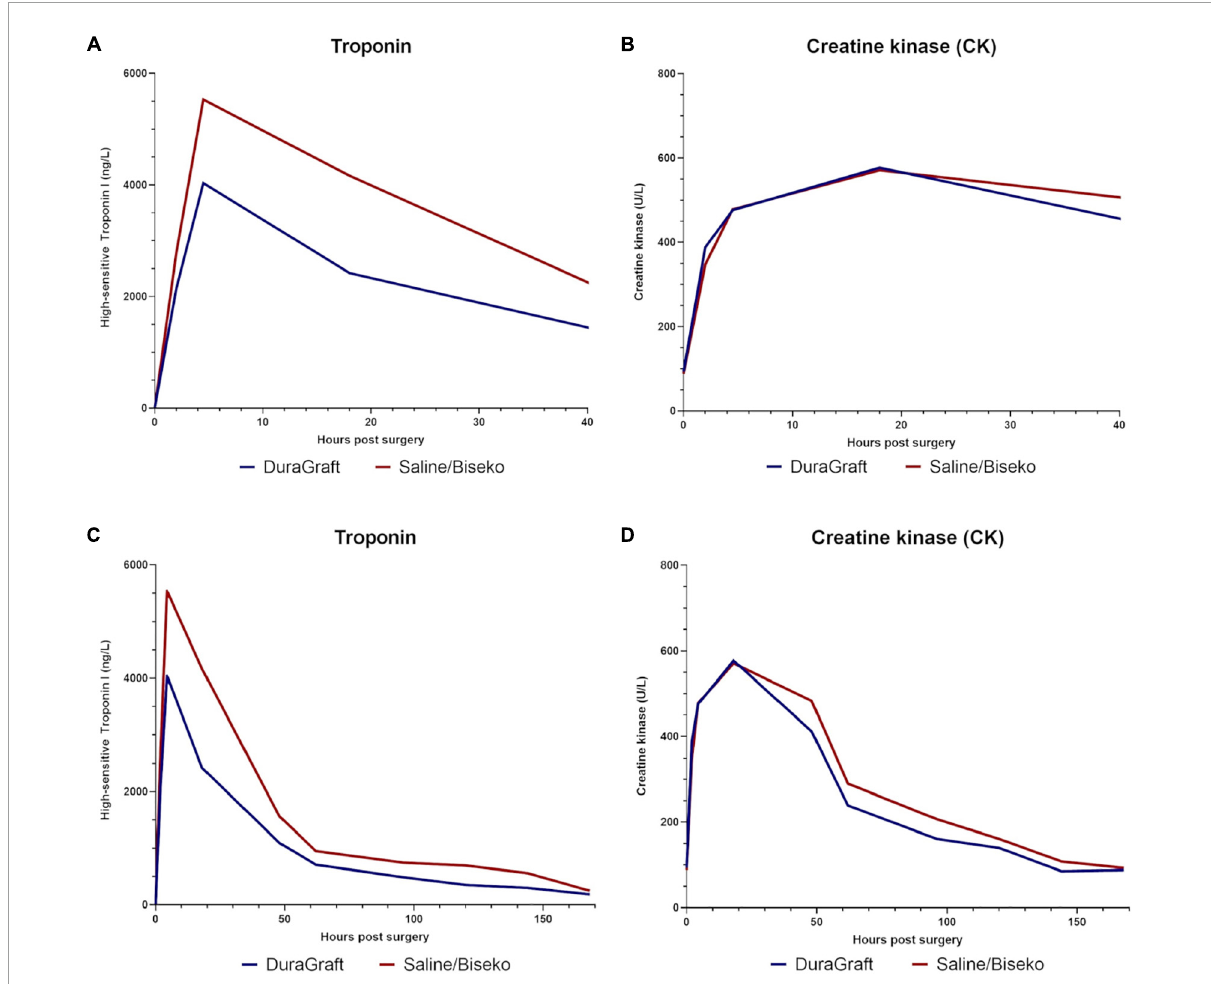
FIGURE3 Median values of high-sensitive Troponin I in nanogram/liter and creatine kinase in units/liter within the first hours post-surgery (A,B) , and during the overall hospital stay (C,D)